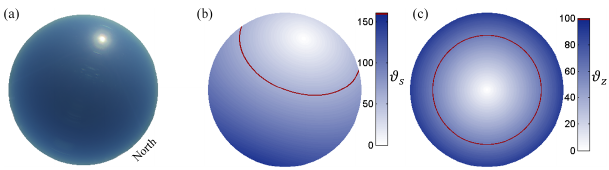
Figure 3. (a) Clear USI image created from a clear-sky library for a solar zenith angle of 60 ◦ on 26 March 2013, 15:00:00UTC. For the image in (a) solar pixel angles and pixel zenith angles are shown in (b) and (c) , respectively. The red lines in (b) and (c) highlight the pixels with ϑ s = 60 ◦ and ϑ z = 60 ◦ , respectively, which are often used in the following chapters to illustrate relationships with cloud optical depth and radiance. North is located on the bottom right cor- ner of the